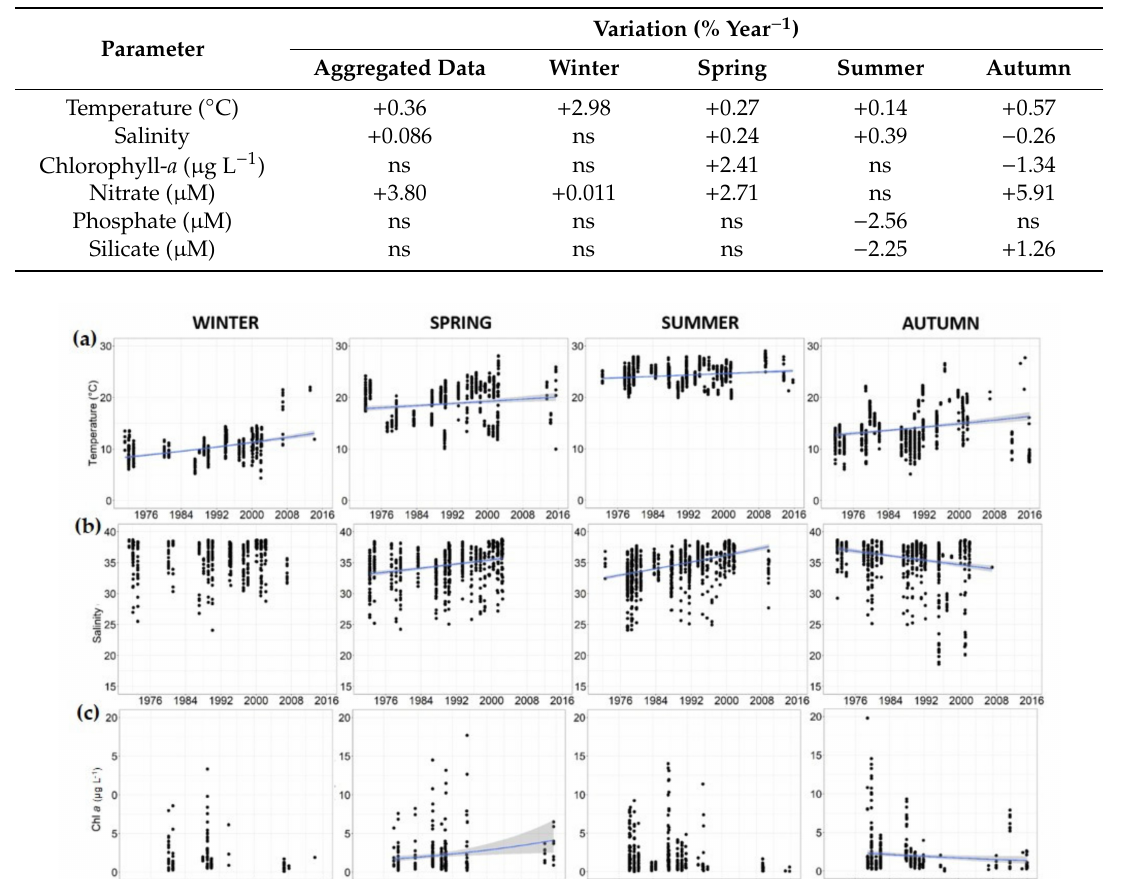
Table 2. Variation (% year − 1 ) of temperature ( ◦ C), salinity, chlorophyll- a ( µ g L − 1 ), nitrate ( µ M), phosphate ( µ M) and silicate ( µ M) as estimated by Generalized Linear Model (GLM) regression. ns: variation not significant.